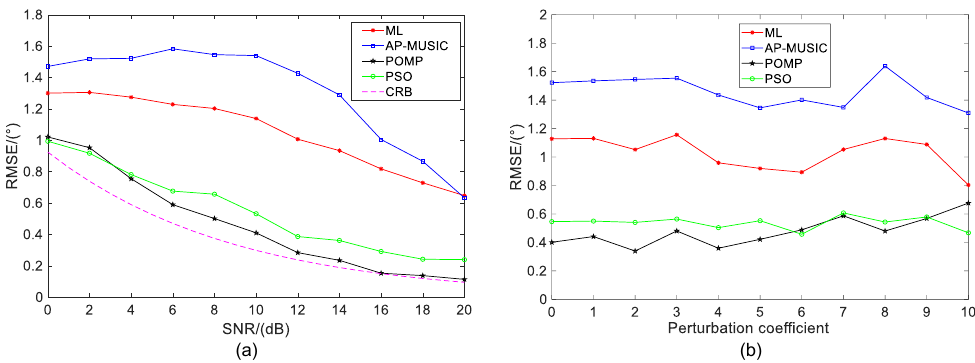
Figure 5. The RMSE result of different algorithms in smooth reflection flat. ( a ) The RMSE results of different algorithms under different SNR values. ( b ) The RMSE results of different algorithms under different perturbation